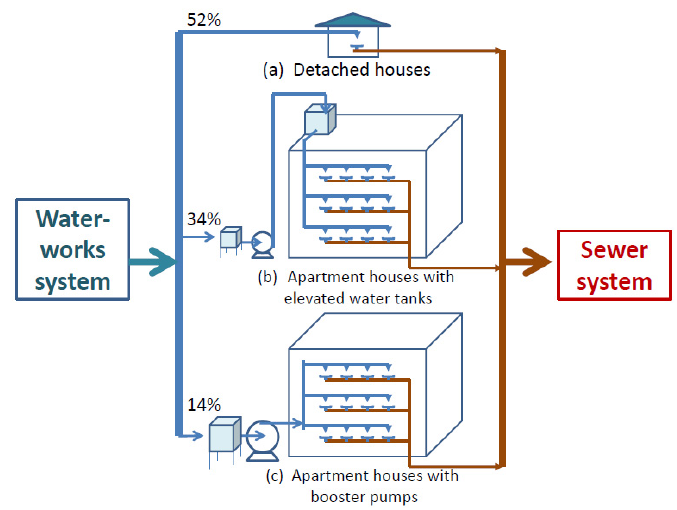
Figure 2. Water delivery systems in